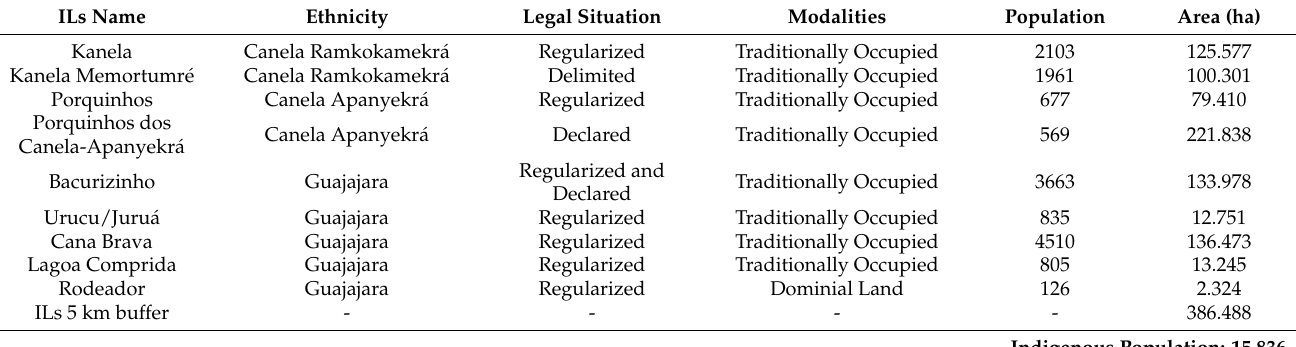
Figure 1. Location of the study area: ( A ) Cerrado biome in Brazil; ( B ) Maranhão (MA) Brazilian state; ( C ) indigenous lands (ILs) and the buffer area. Table 1. Characterization of the indigenous lands (ILs) within the study